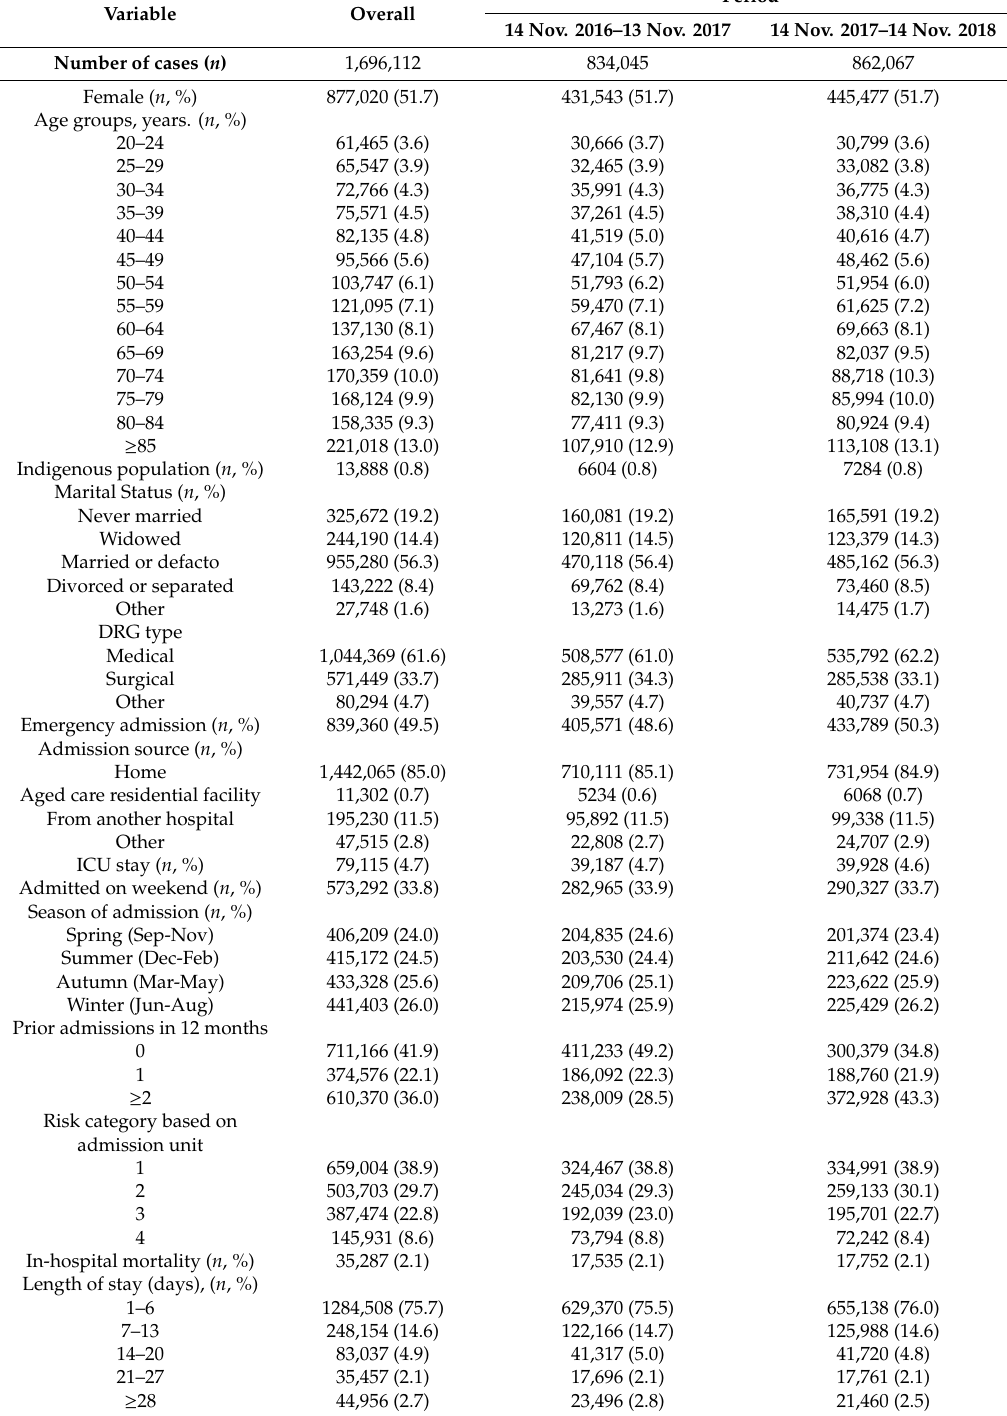
Table 1. Characteristics of patients hospitalized over two years in Victoria,